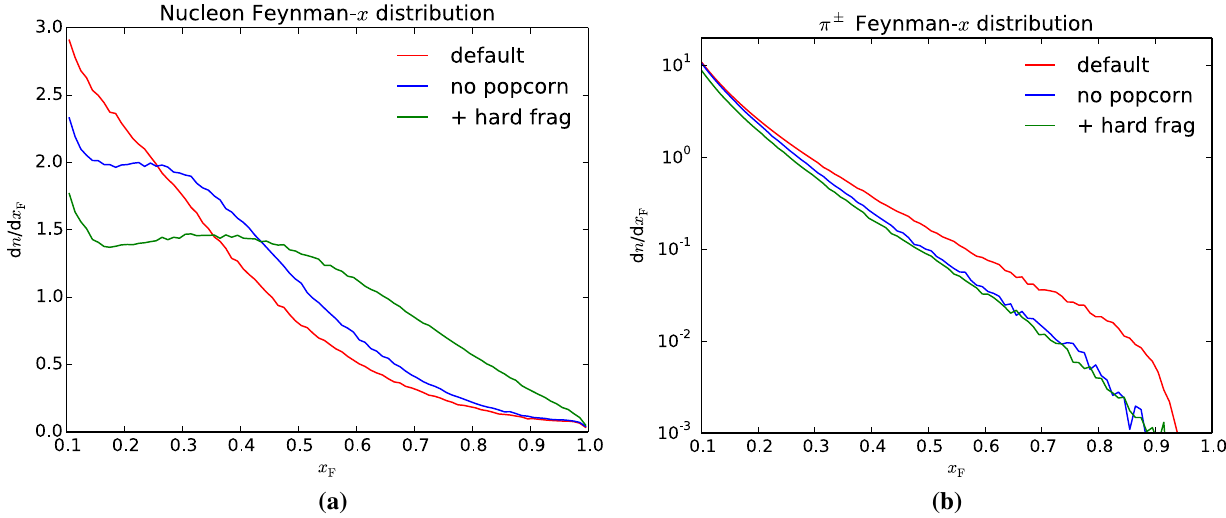
Fig. 5 Feynman- x spectrum of (a) nucleons p / n and (b) π ± for 6 TeV pp collisions with inelastic events, where the quasi-elastic side of single diffraction is not